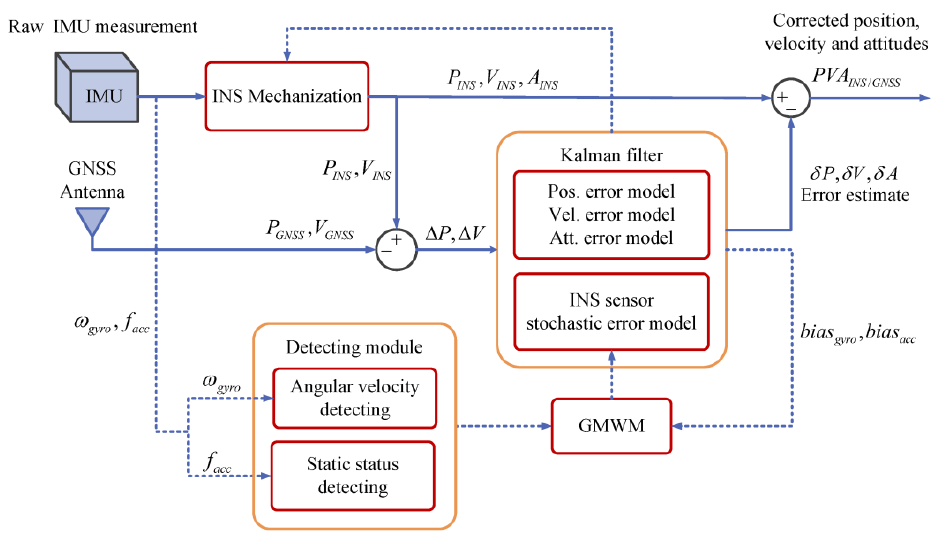
Figure 1. Layout of online stochastic error modeling of inertial sensors in INS/GNSS integration.